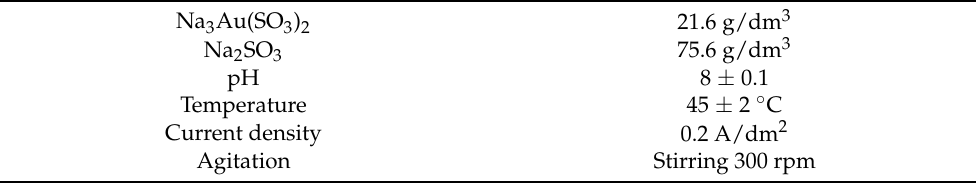
Figure 13. Cross-sectional photograph of a Type B three-dimensionally deformable metal structure (slit width: 10 µ m) fabricated with a Ni electroforming thickness of 10 µ m and Au-plating thickness of 2 µ m. The tapered shape is due to the effect of diffraction of light during exposure. Table 2. Bath composition for Au plating.